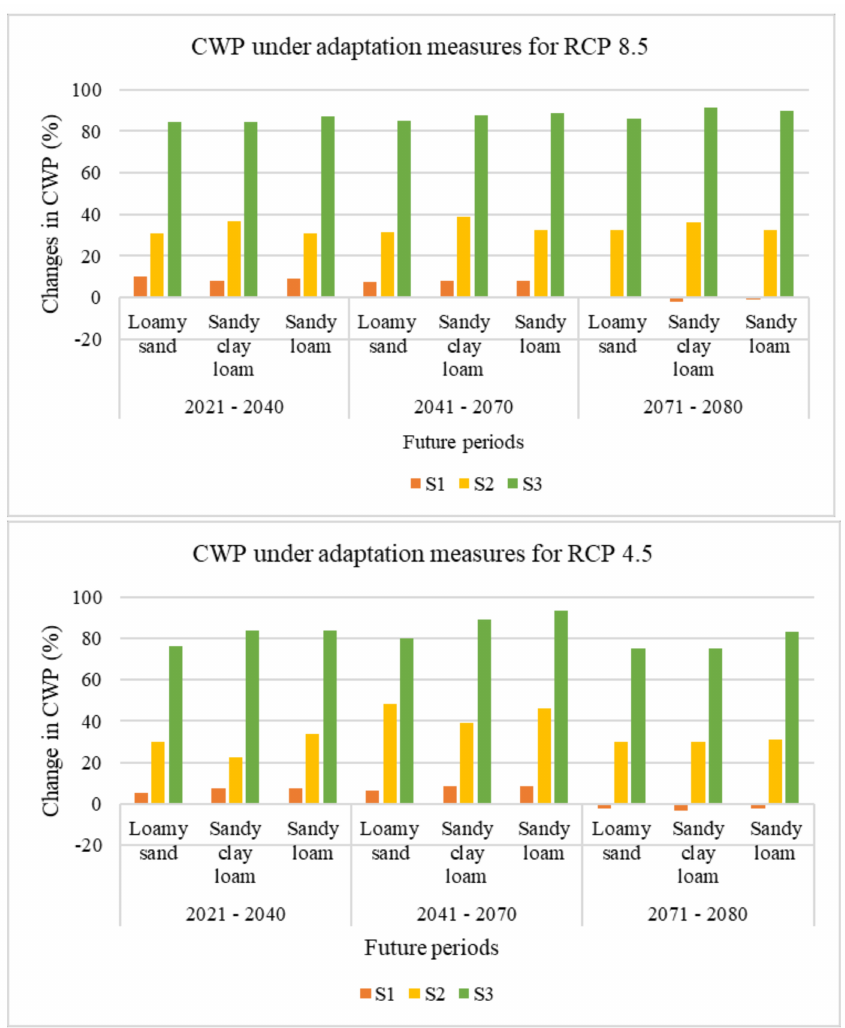
Figure 14. E ff ects of supplemental irrigation (S1), soil fertility at nitrogen rate of 90 kg / ha (S2) and soil fertility at nitrogen rate of 120 kg / ha (S3) on rainfed CWP under RCP 4.5 and RCP